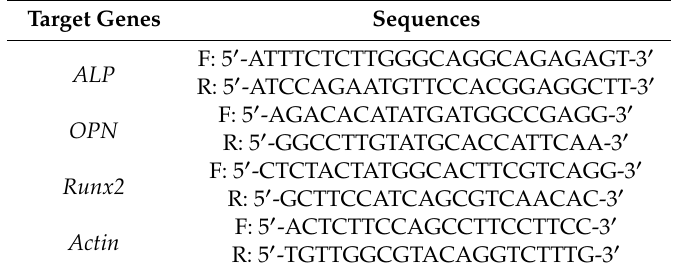
Table 1. Primer sequences used for real-time polymerase chain reaction (PCR) analysis.